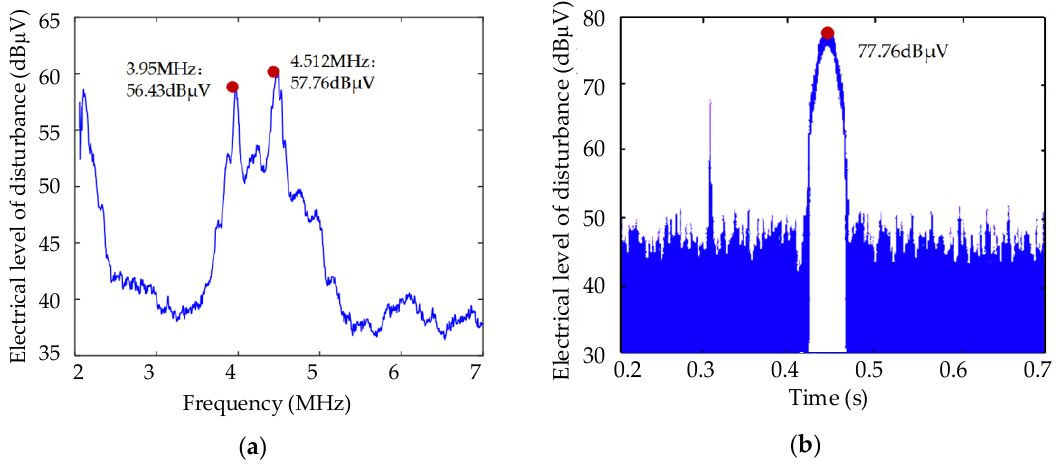
Figure 16. The signal received by on-board antenna: ( a ) The electrical level of self-test data; ( b ) The electrical level of balise message.